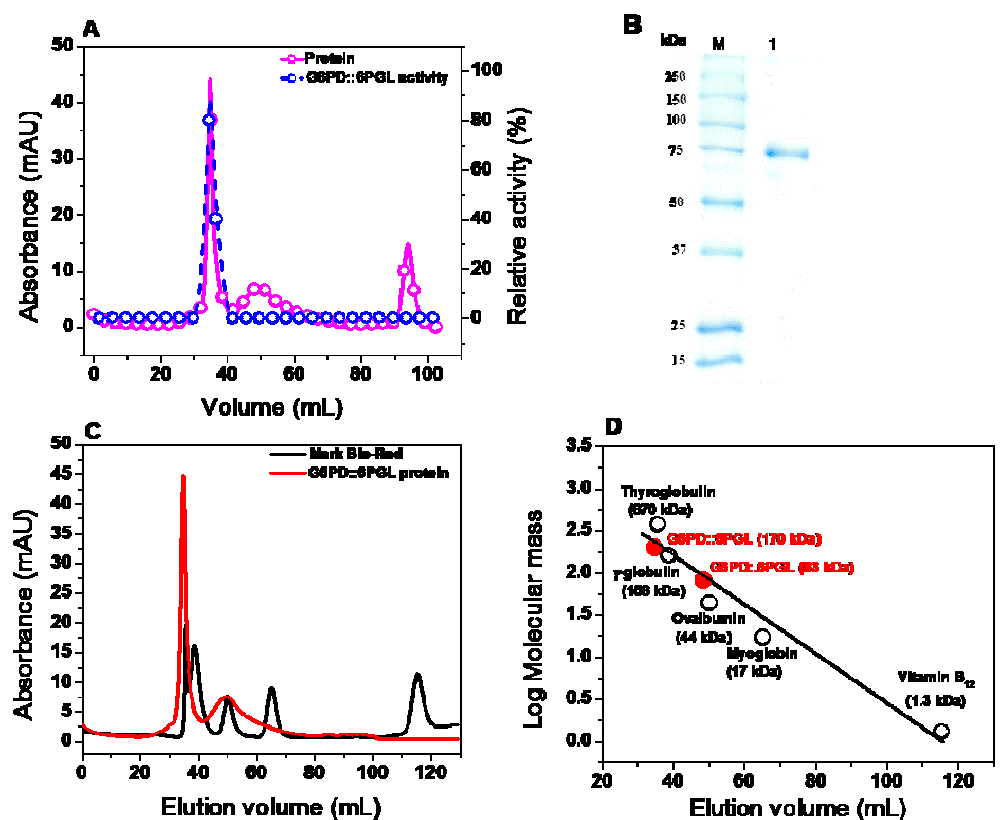
Figure 4. Purification of recombinant G6PD::6PGL protein from G. lamblia. ( A ) Purification by a Sephacryl 100 (16/60) gel filtration column and relative activity. ( B ) Polyacrylamide gel electrophoresis SDS-PAGE analysis of the purified recombinant protein overexpressed in E. coli BL21(DE3) ∆ zwf ::kan r cells. M: Marker Precision Plus Protein Kaleidoscope Standards (Bio-Rad, Hercules, CA, USA). Lane 1: 10 µg of G6PD::6PGL protein purified by Sephacryl 100 (16/60) gel filtration column. SDS-PAGE was stained with colloidal Coomassie Brilliant Blue (R-250) (Sigma-Aldrich, city, USA). ( C ) Size exclusion chromatography of G6PD::6PGL. Black lines indicate Bio-Rad’s gel filtration standard. Gel filtration standards contains thyroglobulin (bovine) (670 kDa), γ -globulin (bovine) (158 kDa), ovalbumin (44 kDa), myoglobin (horse) (17 kDa), and vitamin B12 (1.3 kDa). The red line represents recombinant G6PD::6PGL, whose retention time indicates a molecular mass of 170 kDa. ( D ) Calibration curve of marker proteins drawn with elution volumes versus log of molecular mass for each protein. Molecular mass of G6PD::6PGL is shown on the straight line obtained. Table 1. Summary of the purification of recombinant G6PD::6PGL from Giardia lamblia